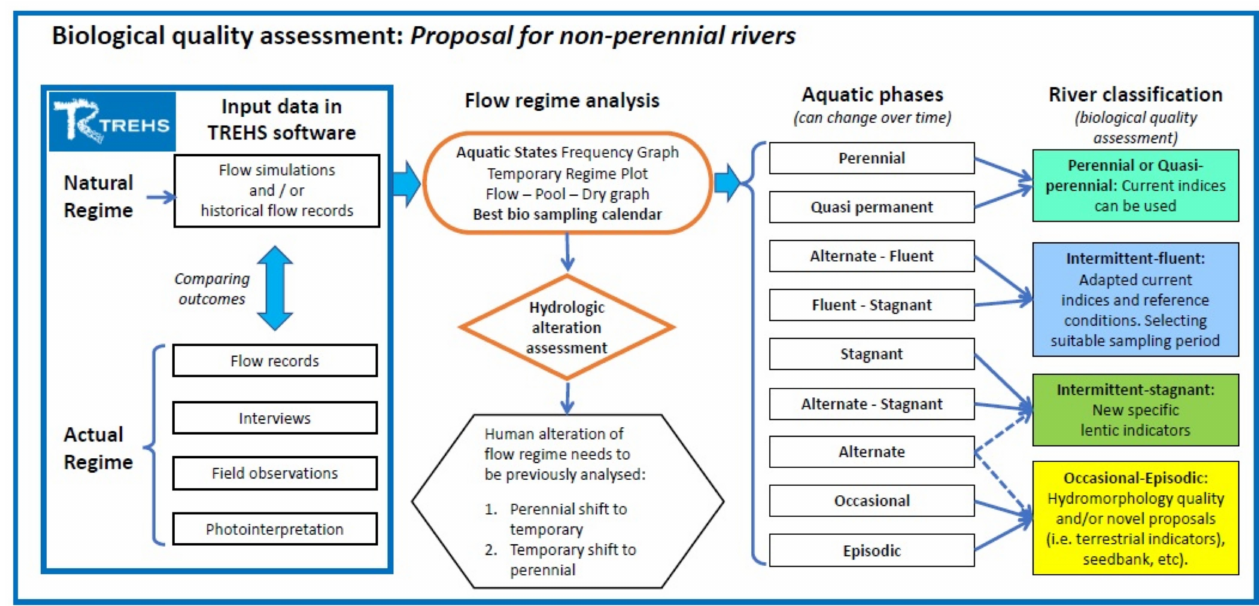
Figure 6. A proposed flowchart to better classify TRs, and correctly assess biological quality.